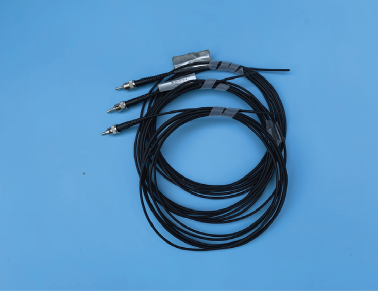
Figure 6: Fiber-optic temperature sensor.